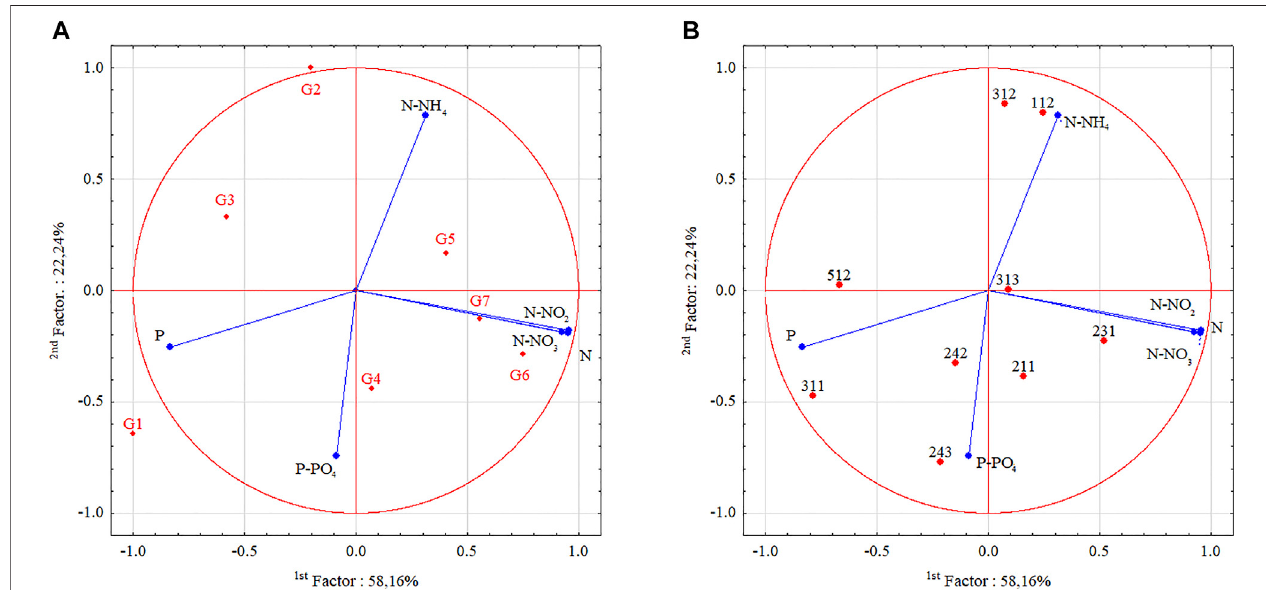
FIGURE 8 | Analysis of the main components of the physicochemical parameters of the G ł uszynka river water in relation to: (A) use of the catchment area of the Kórnik-Zaniemyska Gutter; (B) measurement points of the G ł uszynka river downstream of the lakes (112 — Discontinuous urban fabric; 121 — Industrial or commercial units; 211 — Non-irrigated arable land; 231 — Pastures; 242 — Complex cultivation patterns; 243 — Land principally occupied by agriculture, with signi fi cant areas of natural vegetation; 311 — Broad-leaved forest; 312 — Coniferous forests; 313 — Mixed forest; 324 — Transitional woodland-shrub; 512 — Water bodies).